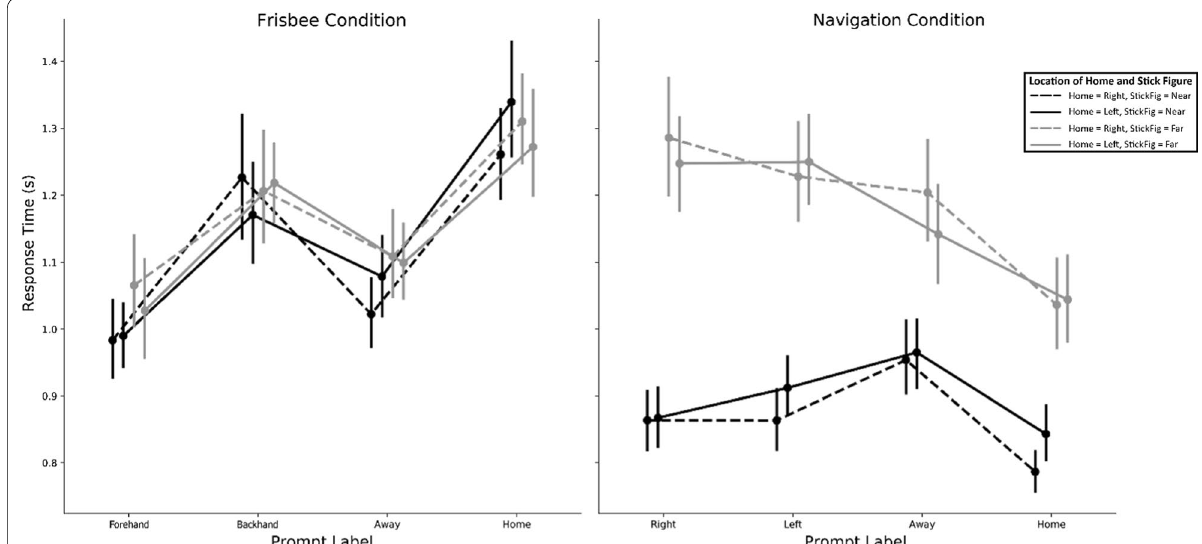
Fig. 7 Reaction times by condition and trial type. Patterns of responses differed across the navigation and frisbee conditions. In the navigation condition, participants were sensitive to whether the stick figure was on the far side of the display, suggesting they were performing the task as if they were the stick figure. Conversely, they were not sensitive to the location of the stick figure in the frisbee condition. Instead, in the